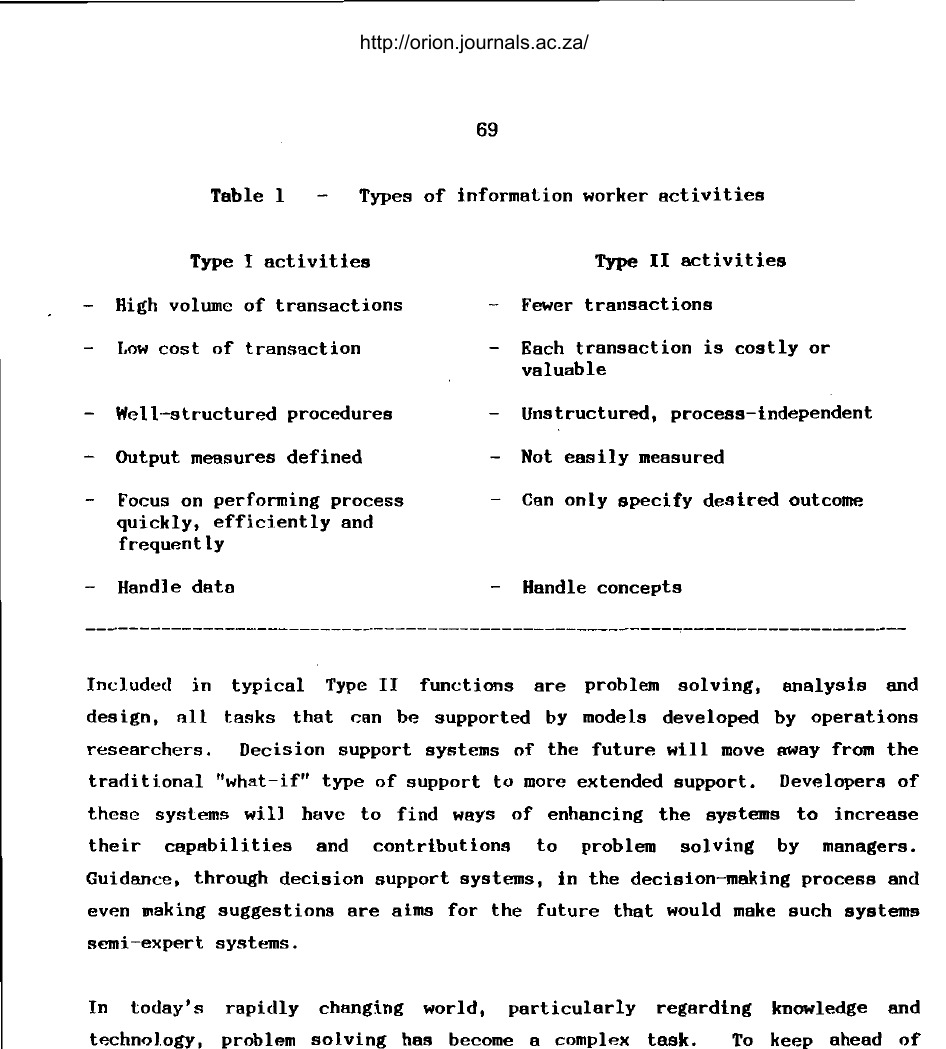
Types of information worker